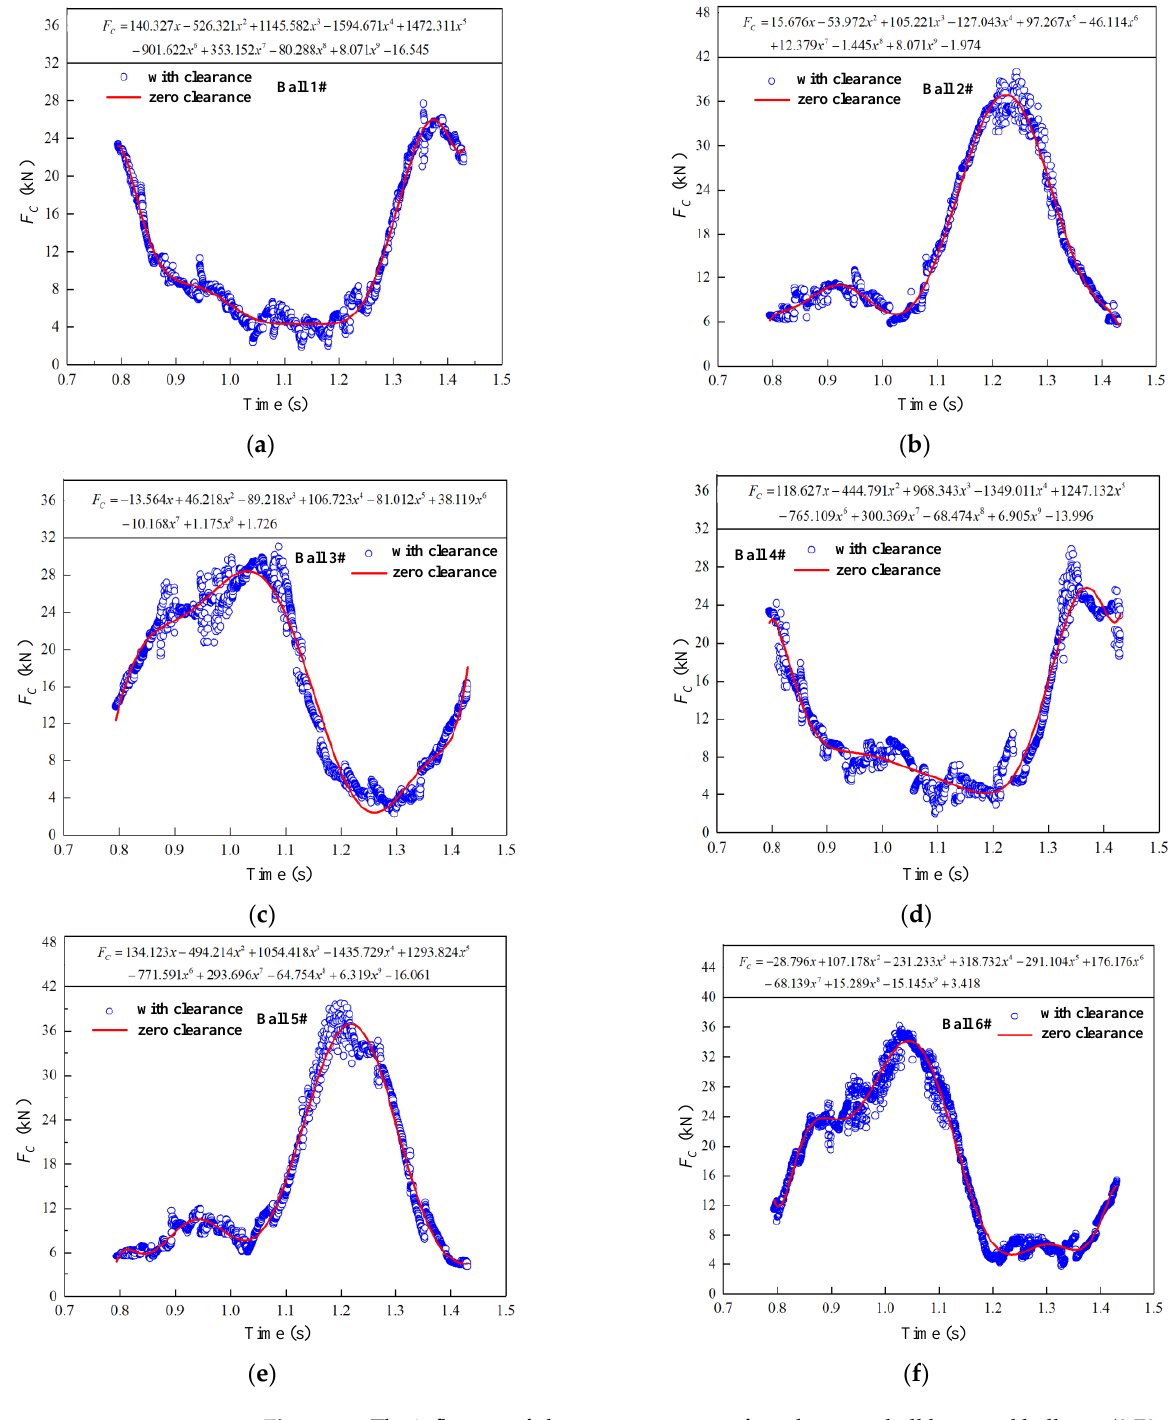
Figure 14. The influence of clearance on contact force between ball keys and ball seat (0.79 s – 1.43 s). ( a ) Contact force of ball key 1; ( b ) Contact force of ball key 2; ( c ) Contact force of ball key 3; ( d ) Contact force of ball key 4; ( e ) Contact force of ball key 5; ( f ) Contact force of ball key 6.